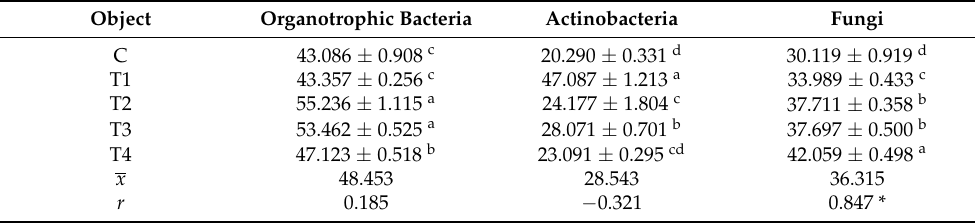
Table 1. Effect of tebuconazole on the colony development index (CD) of microorganisms.